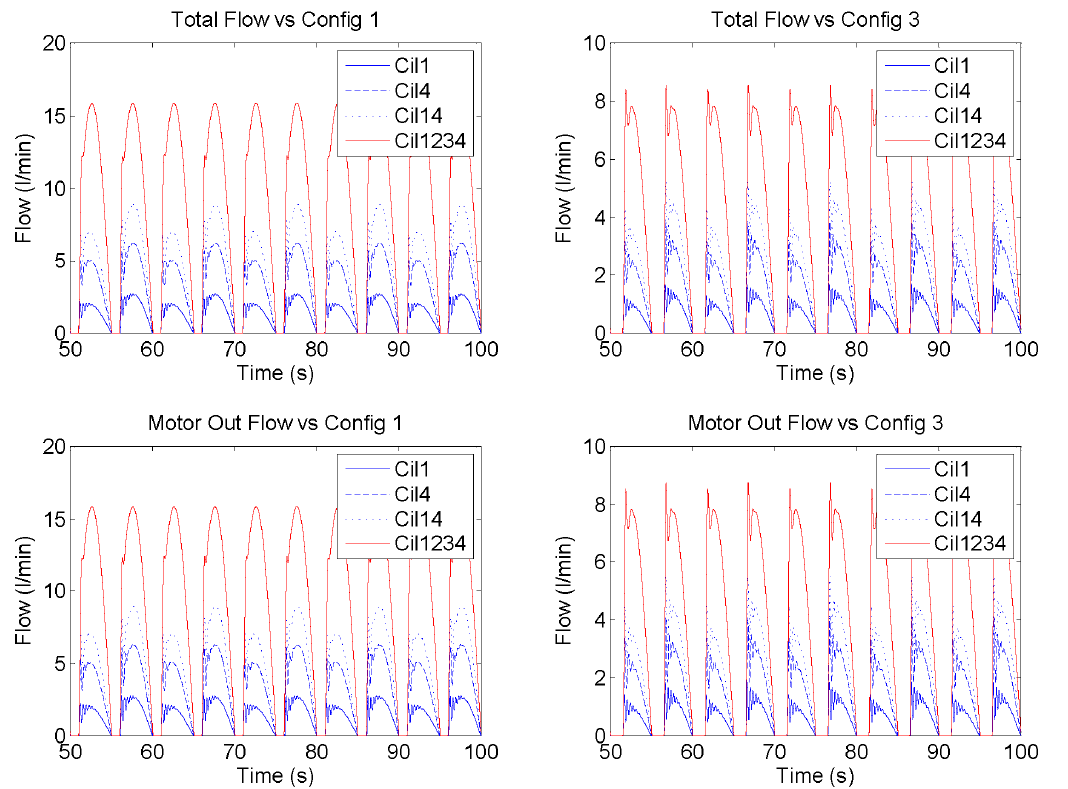
Figure 10. Instantaneous flow at the PTO input and output versus activated cylinders using configuration 1 and 3.